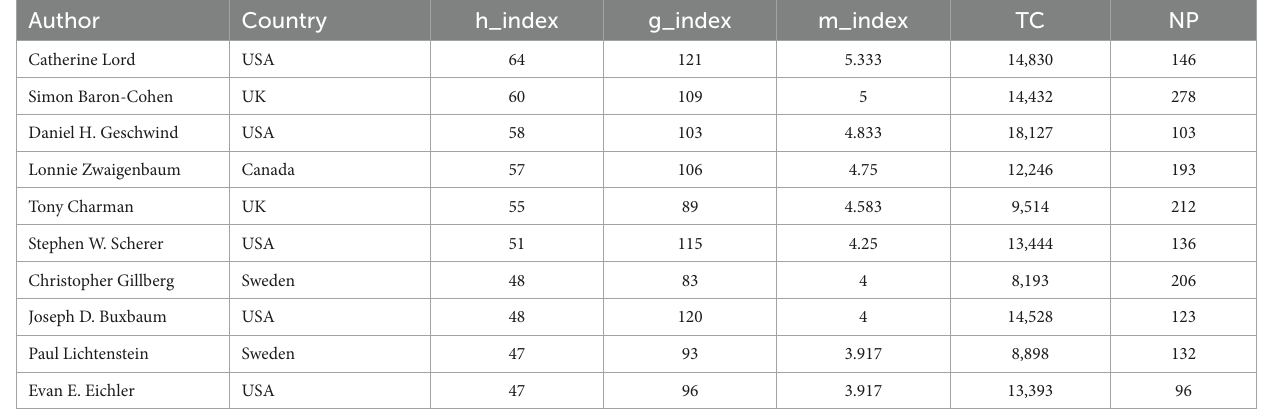
TABLE 4 Top 10 most effective authors contributing to autism